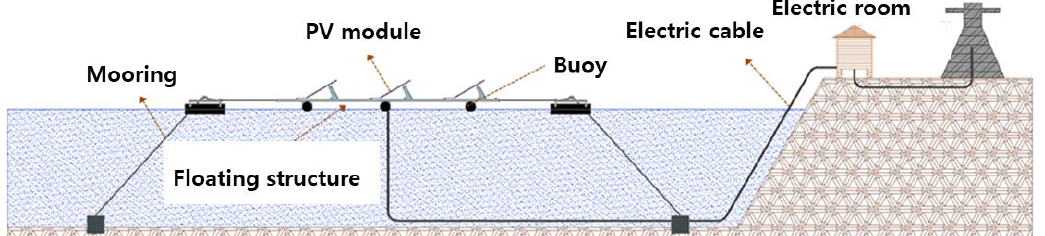
Figure 1. A schematic of floating PV power generation system.